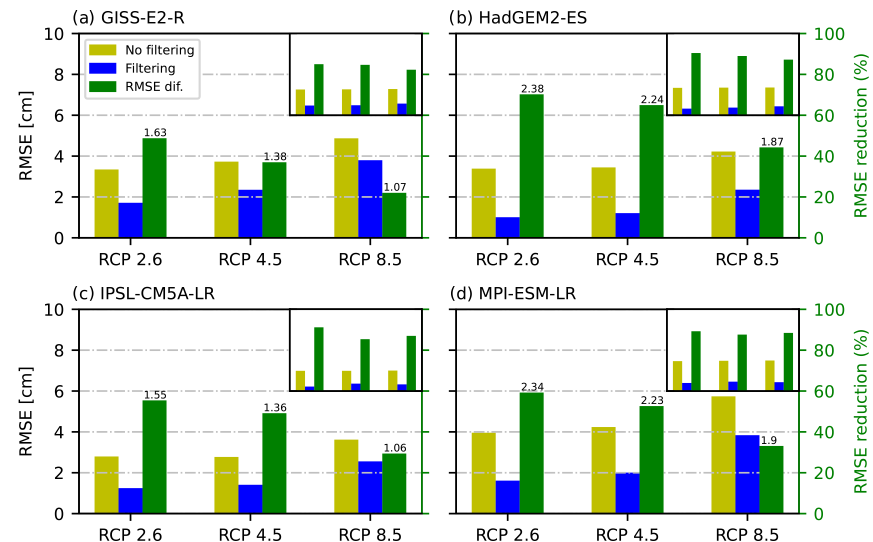
Figure 9. Area-weighted average RMSE for RCP2.6, 4.5, and 8.5, indicating whether the ensemble member is (blue) or is not (yellow) filtered via LFCA. Green indicates relative RMSE reduction between approaches (%), whereas values on top of the bars are the absolute differences in centimeters. Different panels represent different CMIP5 models. The main panel includes simulation data up to 2300, whereas the small inset in the right-hand top corner shows RMSE results up to 2100. Small insets share the same axes as main